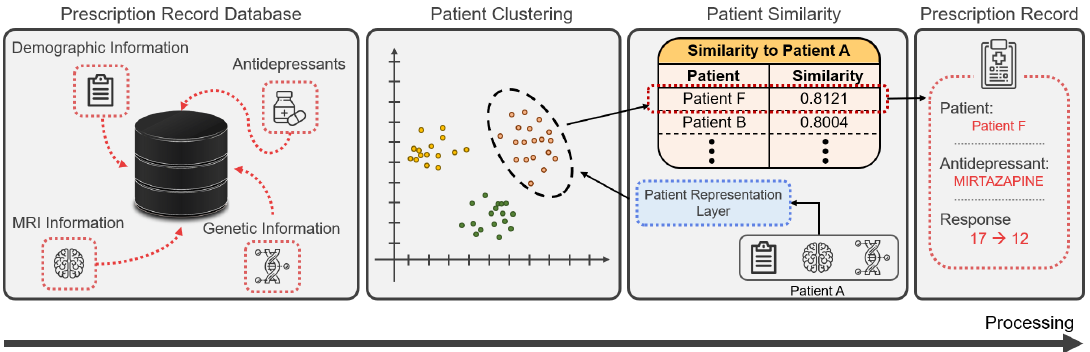
Figure 4. A use case of clinical decision support systems using the similarity between